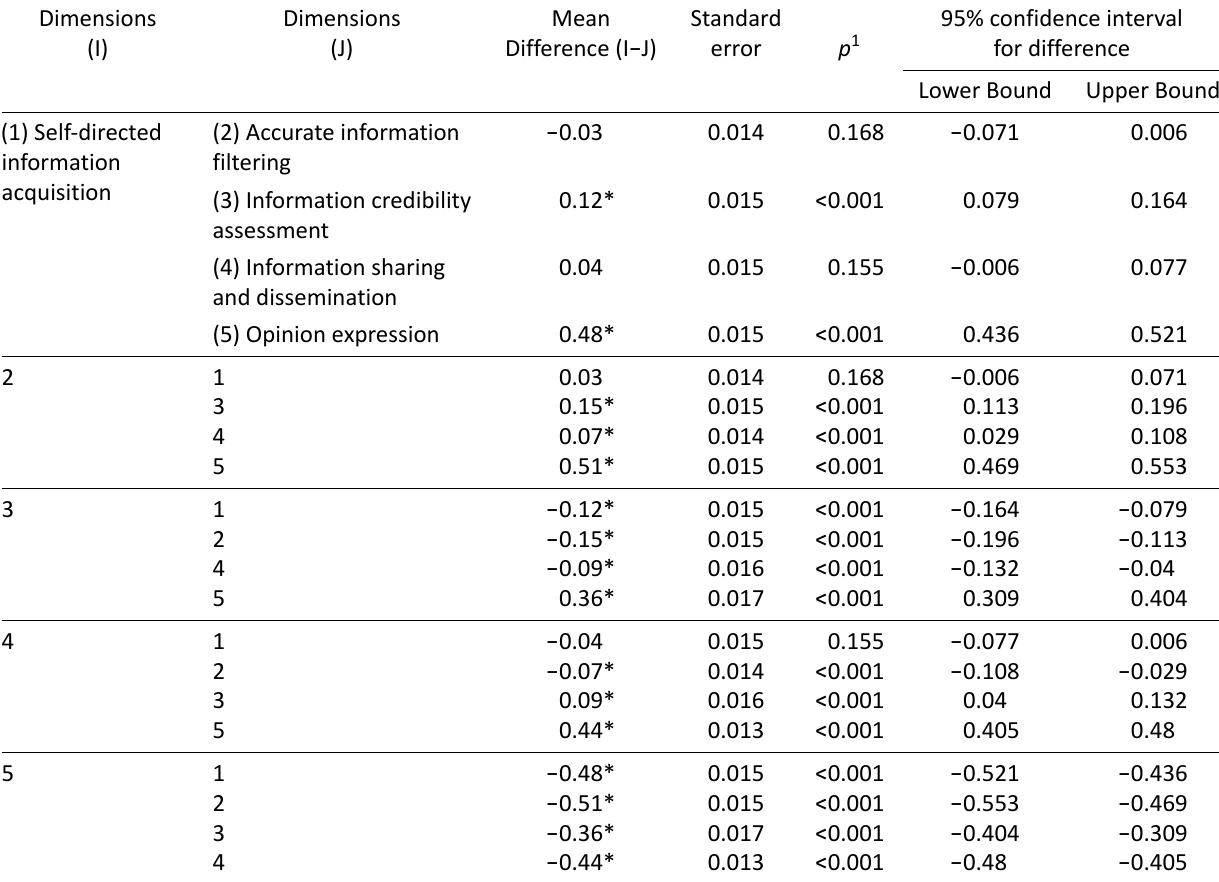
Table 6. Results of pairwise comparisons.